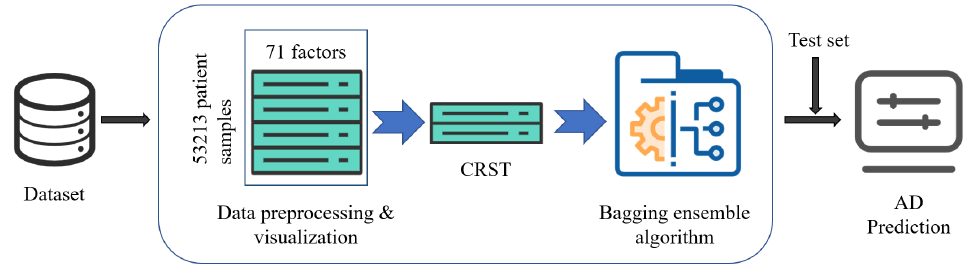
Figure 1. The structure of the CRST-Bagging model for AD screening.